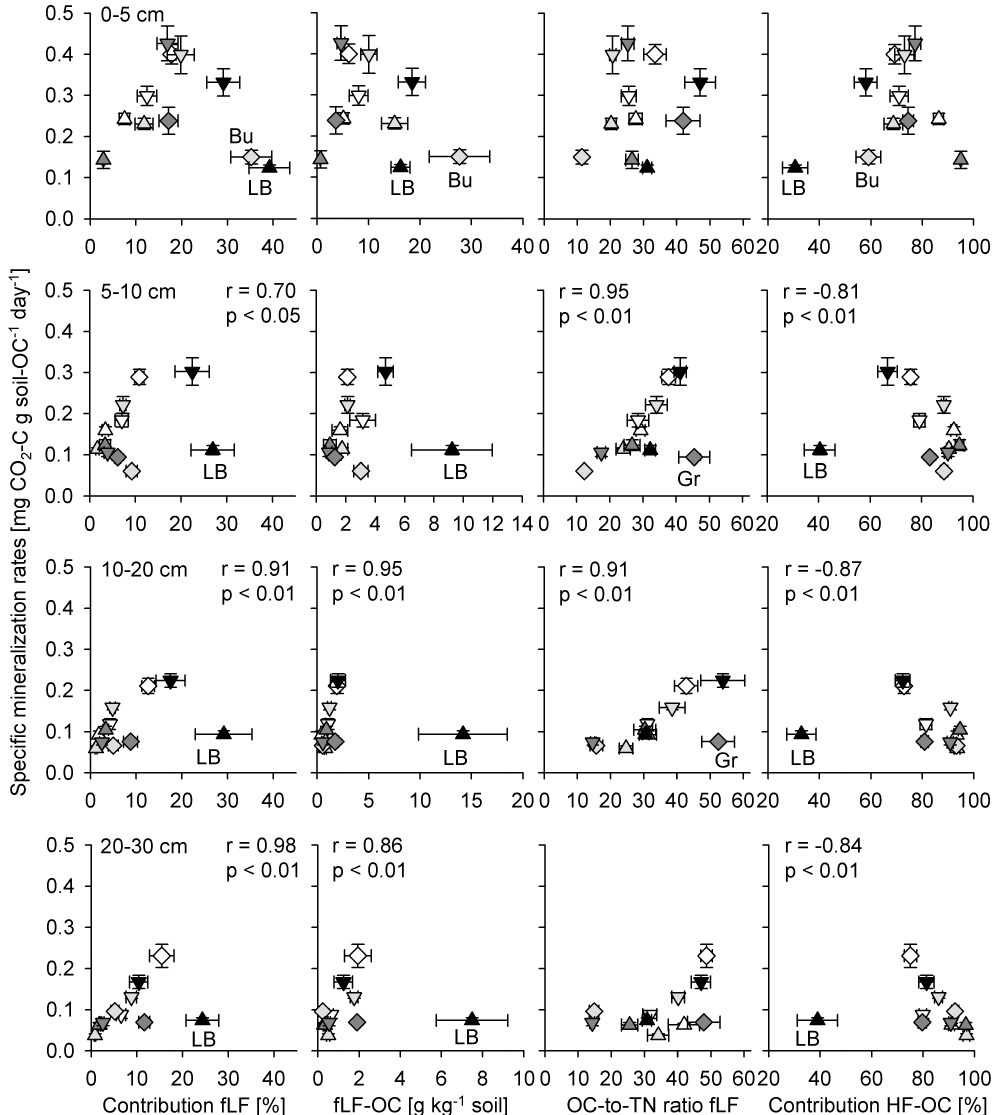
Fig. 11. Specific mineralization rates in relation to the proportion of free light fraction OC (fLF-OC), heavy fraction OC (HF-OC), the amount of fLF-OC per gram soil and the OC-to-TN ratio of the fLF for soil depths 0–5cm, 5–10cm, 10–20cm, 20–30cm. The sites Le Bray (black filled triangle up, LB) and Grignon (dark grey diamond, Gr) were excluded from correlation analyses (see text for details) (black: coniferous forest, dark grey: croplands, light gray: grasslands, white: deciduous